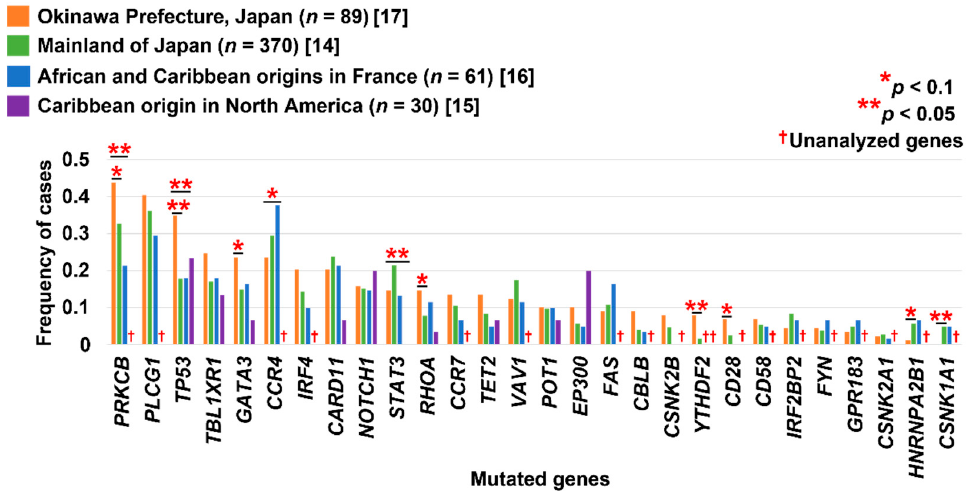
Figure 3. Heterogeneity of mutational profiles depending on the geographical region [14–17]. The p -value was calculated with two-sided Fisher’s exact test.